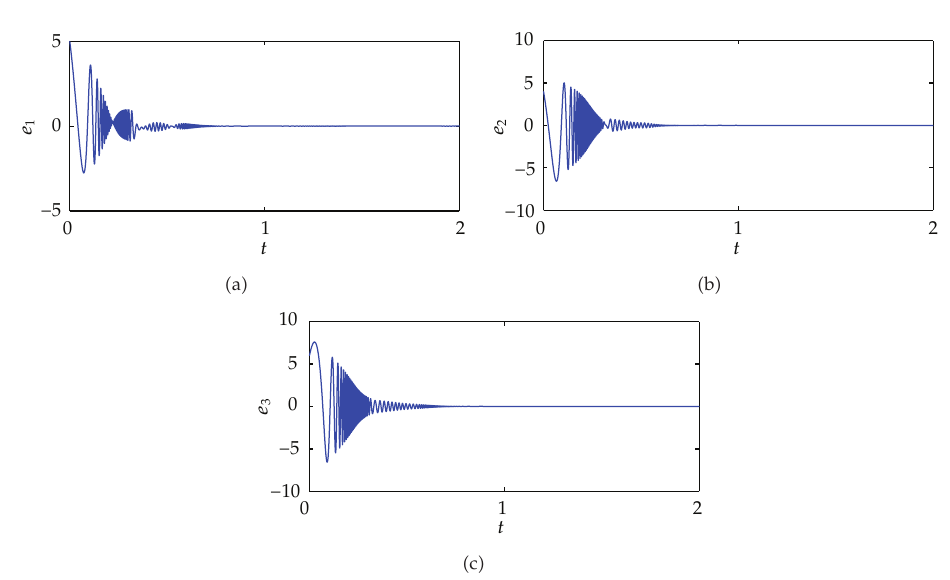
Figure 3: The modified function projective synchronization errors between the fractional-order Lorenz system (cid:2) 3.1 (cid:3) and the fractional-order hyperchaotic system (cid:2) 3.2 (cid:3) .